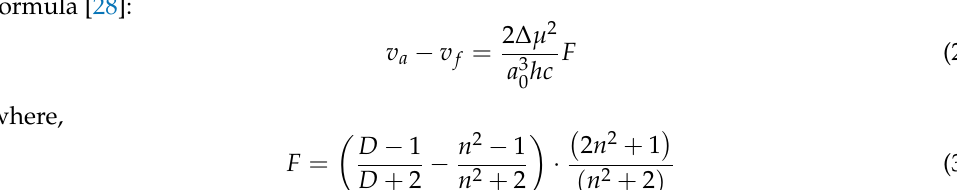
Table 2. Photochemical characteristics of studied compounds in different solvents. Solvent